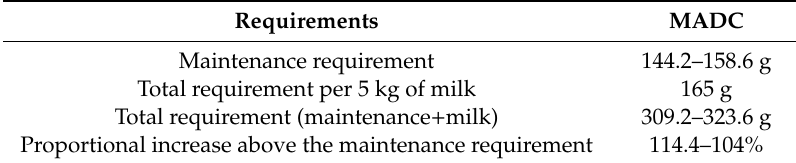
Table 4. Daily MADC requirements for a 300 kg BW lactating donkey according to INRA 1